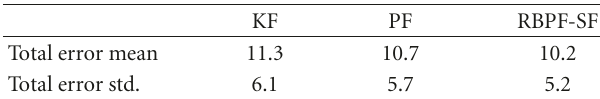
Table 2: Comparisons of tracking errors in cm of EKF and odometer. Odometer EKF Total mean 8.1 5.7